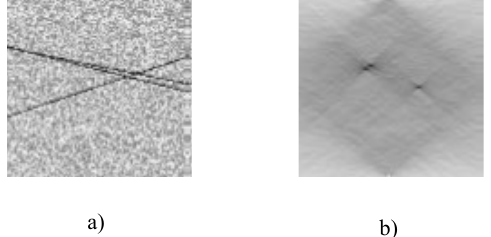
Figure 1. a) An image with two lines that uniformly distributed and uncorrelated noise. b) The corresponding discrete Radon transformation (Toft, 1996).